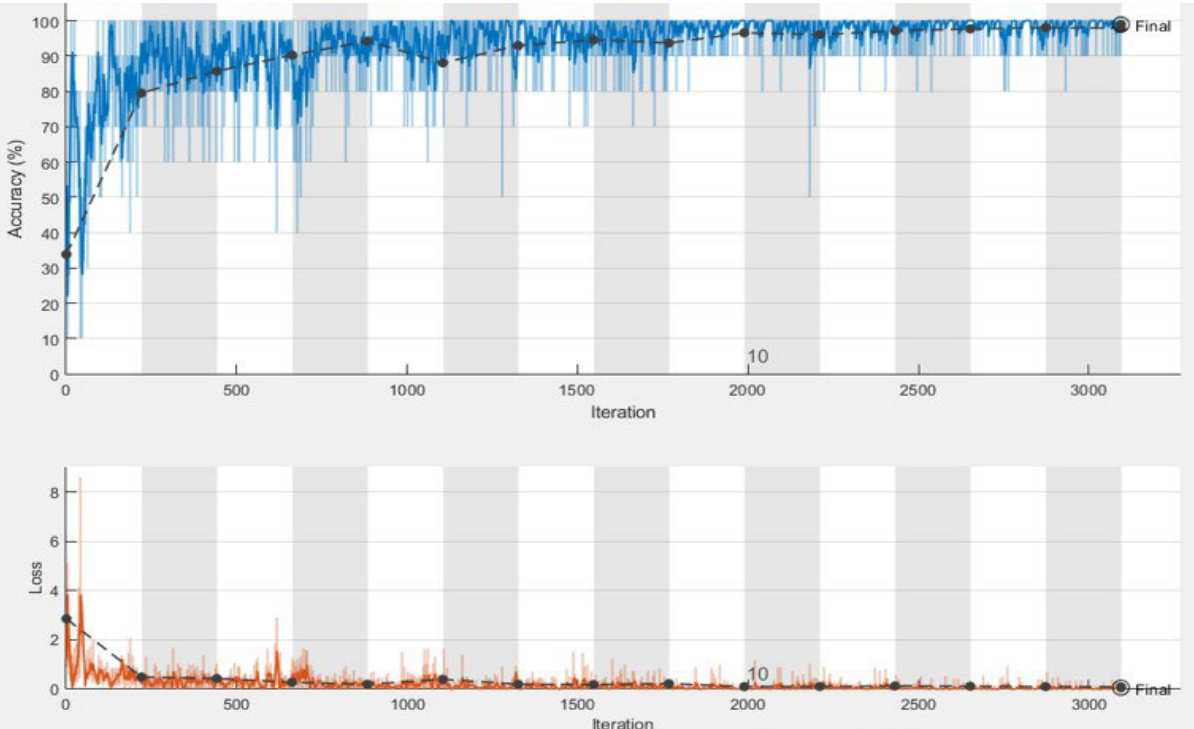
Figure 4. Training and validation accuracy and loss plots of Inceptionresnetv2 (black line shows the validation accuracy and loss. Also, the blue lines shows training accuracy and red line shows train- ing